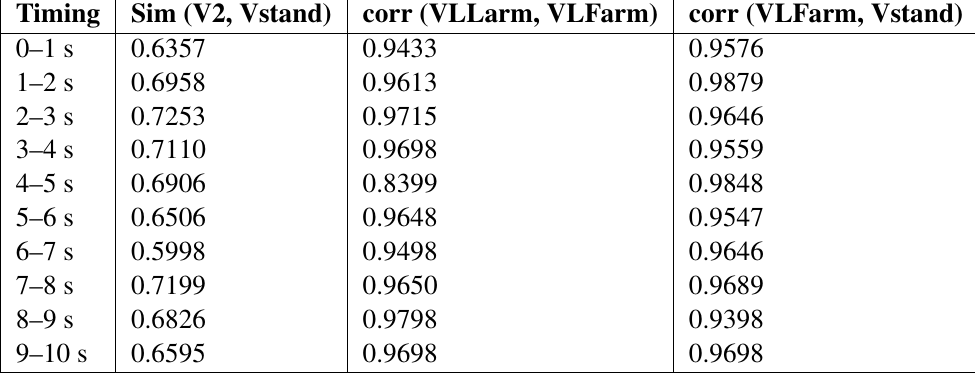
Table 4 Parameters related to the posture of the left arm to be measured.